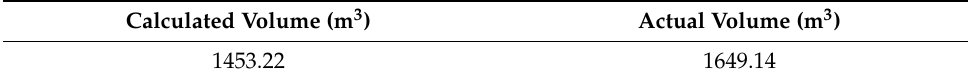
Table 5. Results of volume calculation from the case